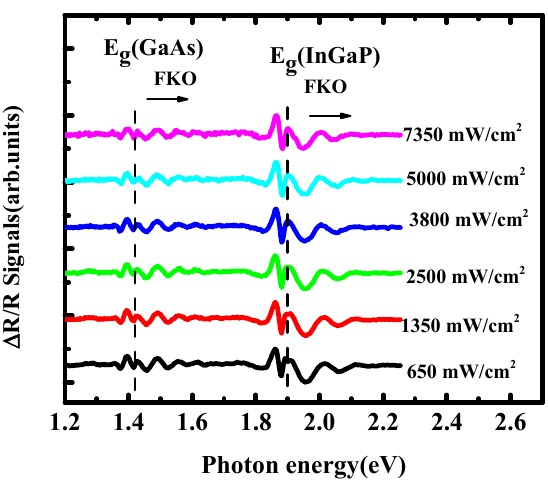
Figure 7. The OBPR spectra of InGaP/GaAs dual junction solar cell as a function of CW light ( λ = 404 nm) intensity (I OB ) at 300 K.